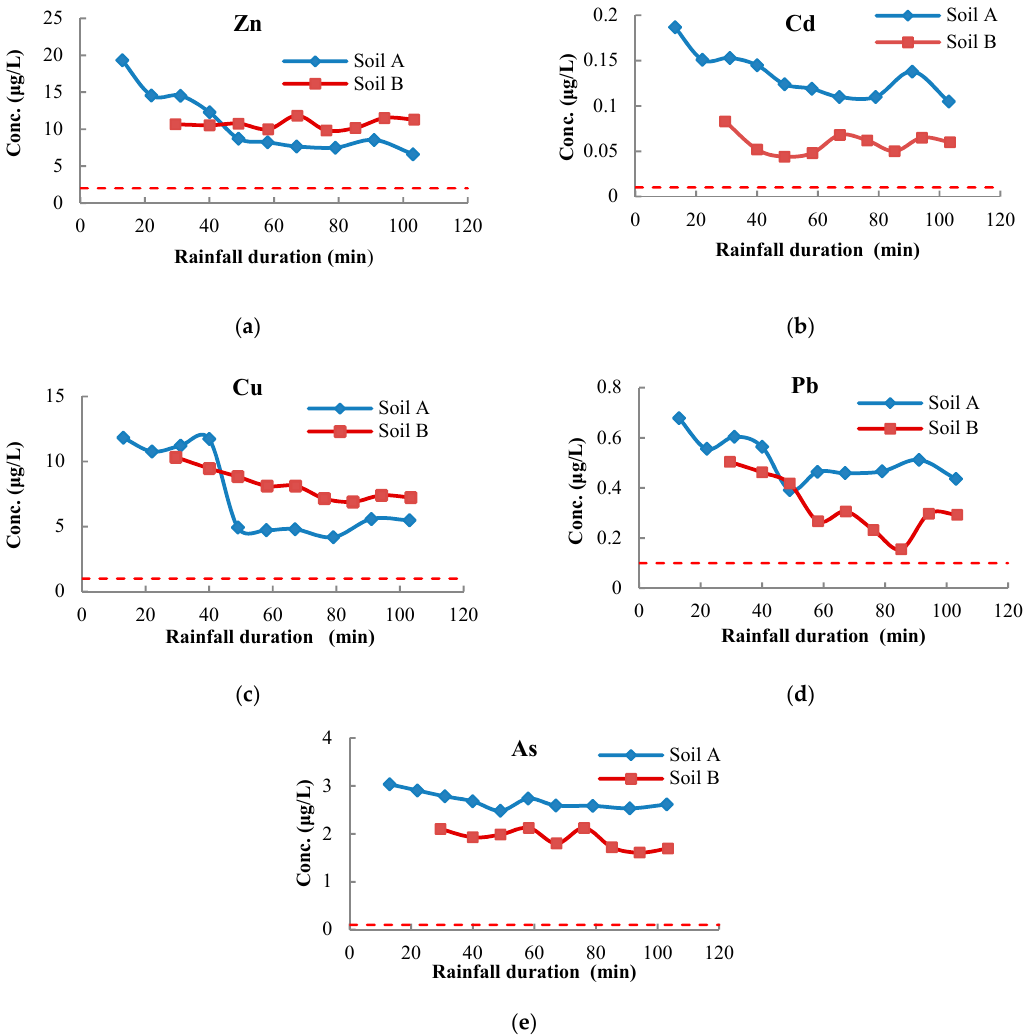
Figure 4. Concentrations of dissolved: ( a ) Zn; ( b ) Cd; ( c ) Cu; ( d ) Pb; and ( e ) As from soil A and soil B during the simulated-rainfall. (The red dash lines represent HM level in water classified as Class V in the Surface Water Environmental Standards in China (GB3838-2002)).